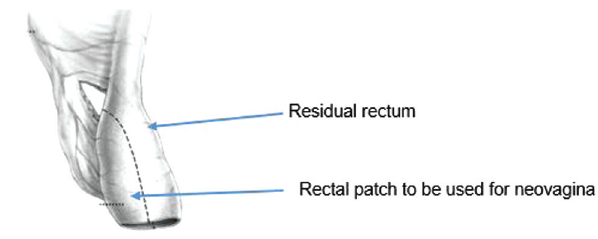
Fig. 3 For a rectal patch, the megarectum is divided longitudinally with care to preserve its blood